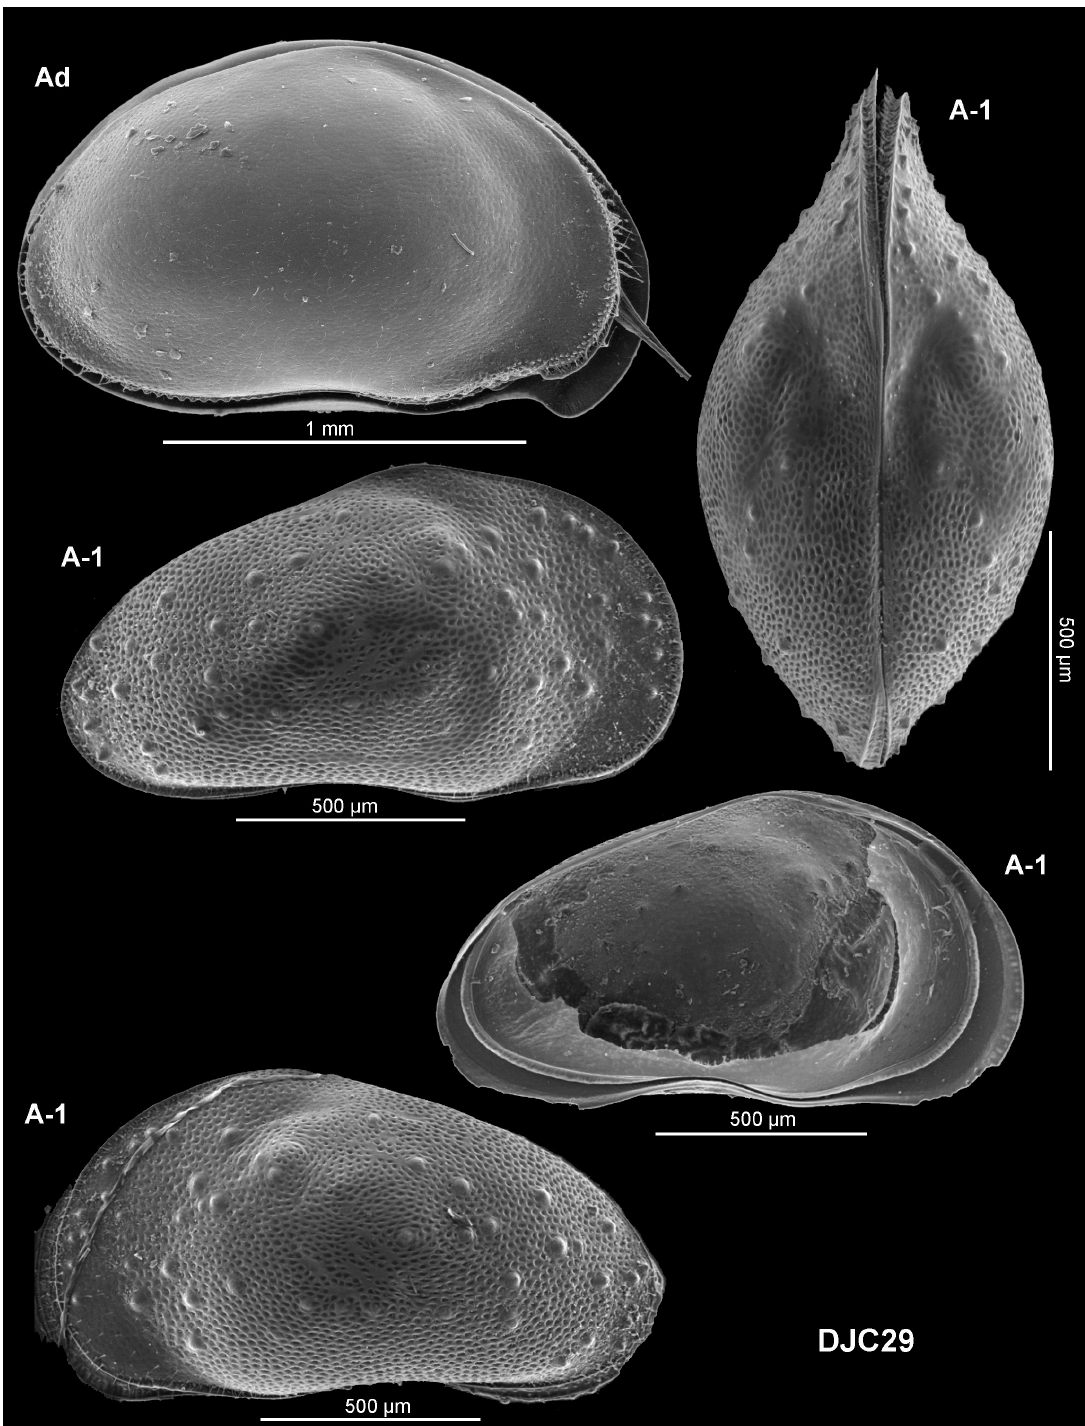
Fig. 23. External views of Bennelongia gwelupensis Martens et al ., 2012 from Katanning Road pool, except for the middle image on the right which shows an internal view of a LV. Top left image represents the right lateral view of an adult carapace, with the antero-ventral beak-like expansion of the LV. In the internal view of the A-1 LV, note the depressions seen internally that mirror the cones that occur externally. A prominent inner list is visible all along the periphery of the valve, except in the dorsal region. This latter feature is usually not seen in juveniles